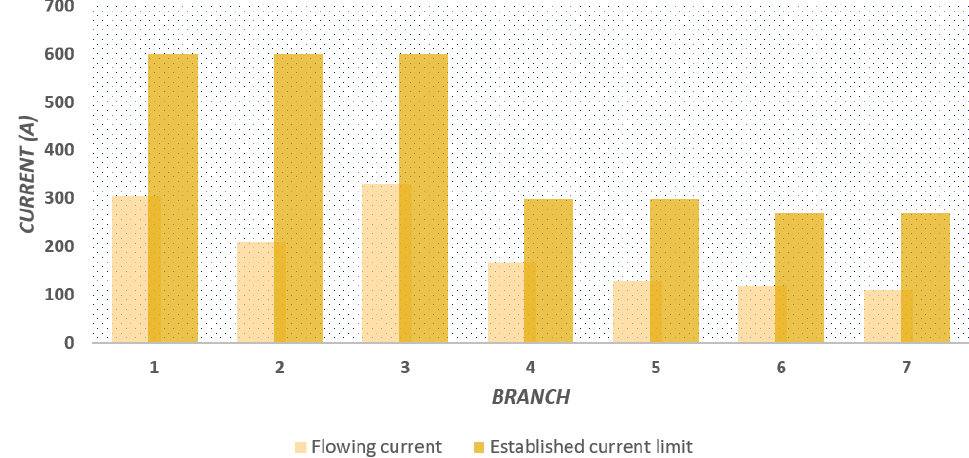
Figure 14. Loadability levels present in the branches of the three-phase 8-bus distribution system under an unbalanced load scenario.